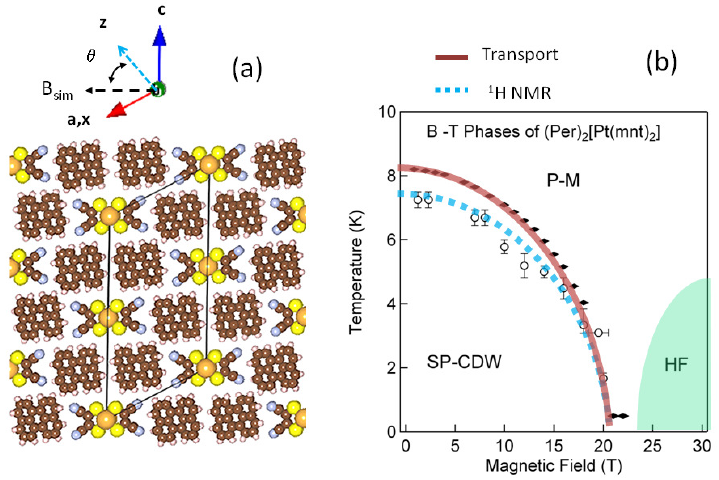
Figure 1. ( a ) View of Per [Pt(mnt) 2 crystallographic coordinate system direction ( θ = 67°) used in the the Pt sites on the [Pt(mnt) closest Pt-Pt distance is 4.125 Å (along the b Per [Pt(mnt) ] showing the 2 2 (paramagnetic-metallic), and HF splitting of NMR spectra (open symbols) and metal transport measurements (solid symbols) for a field applied along the